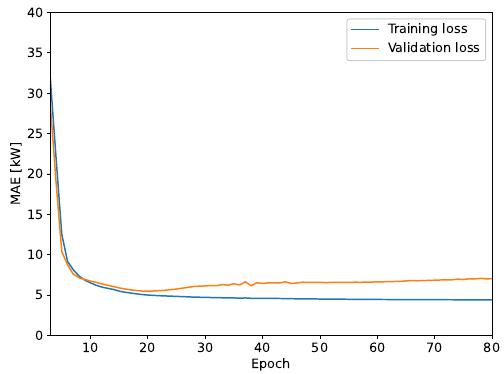
Figure 10. Loss curve in power generation estimation.